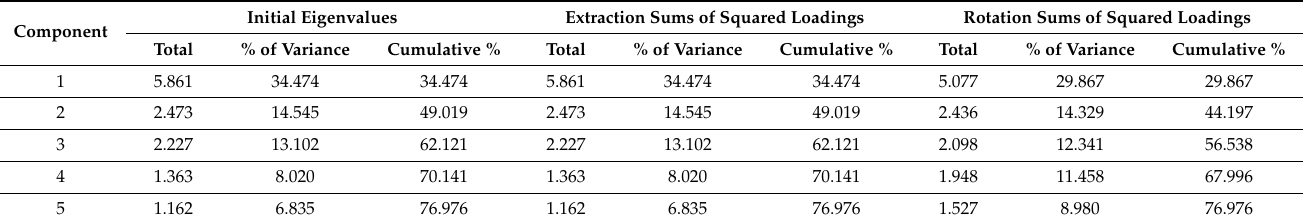
Table 4. Selecting the PCs according to the total